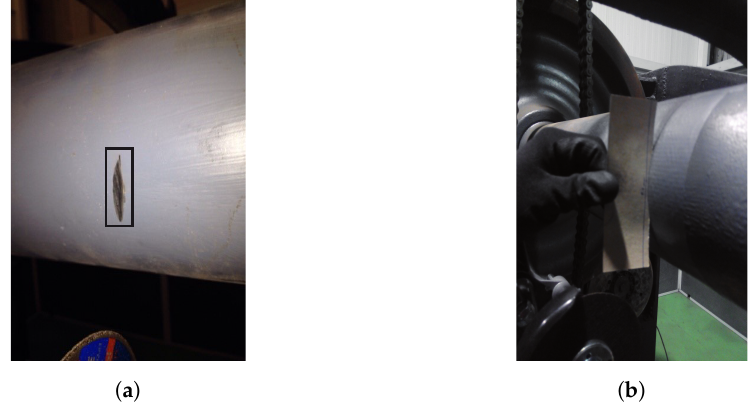
Figure 5. Defect level D1: ( a ) surface detail; ( b ) depth